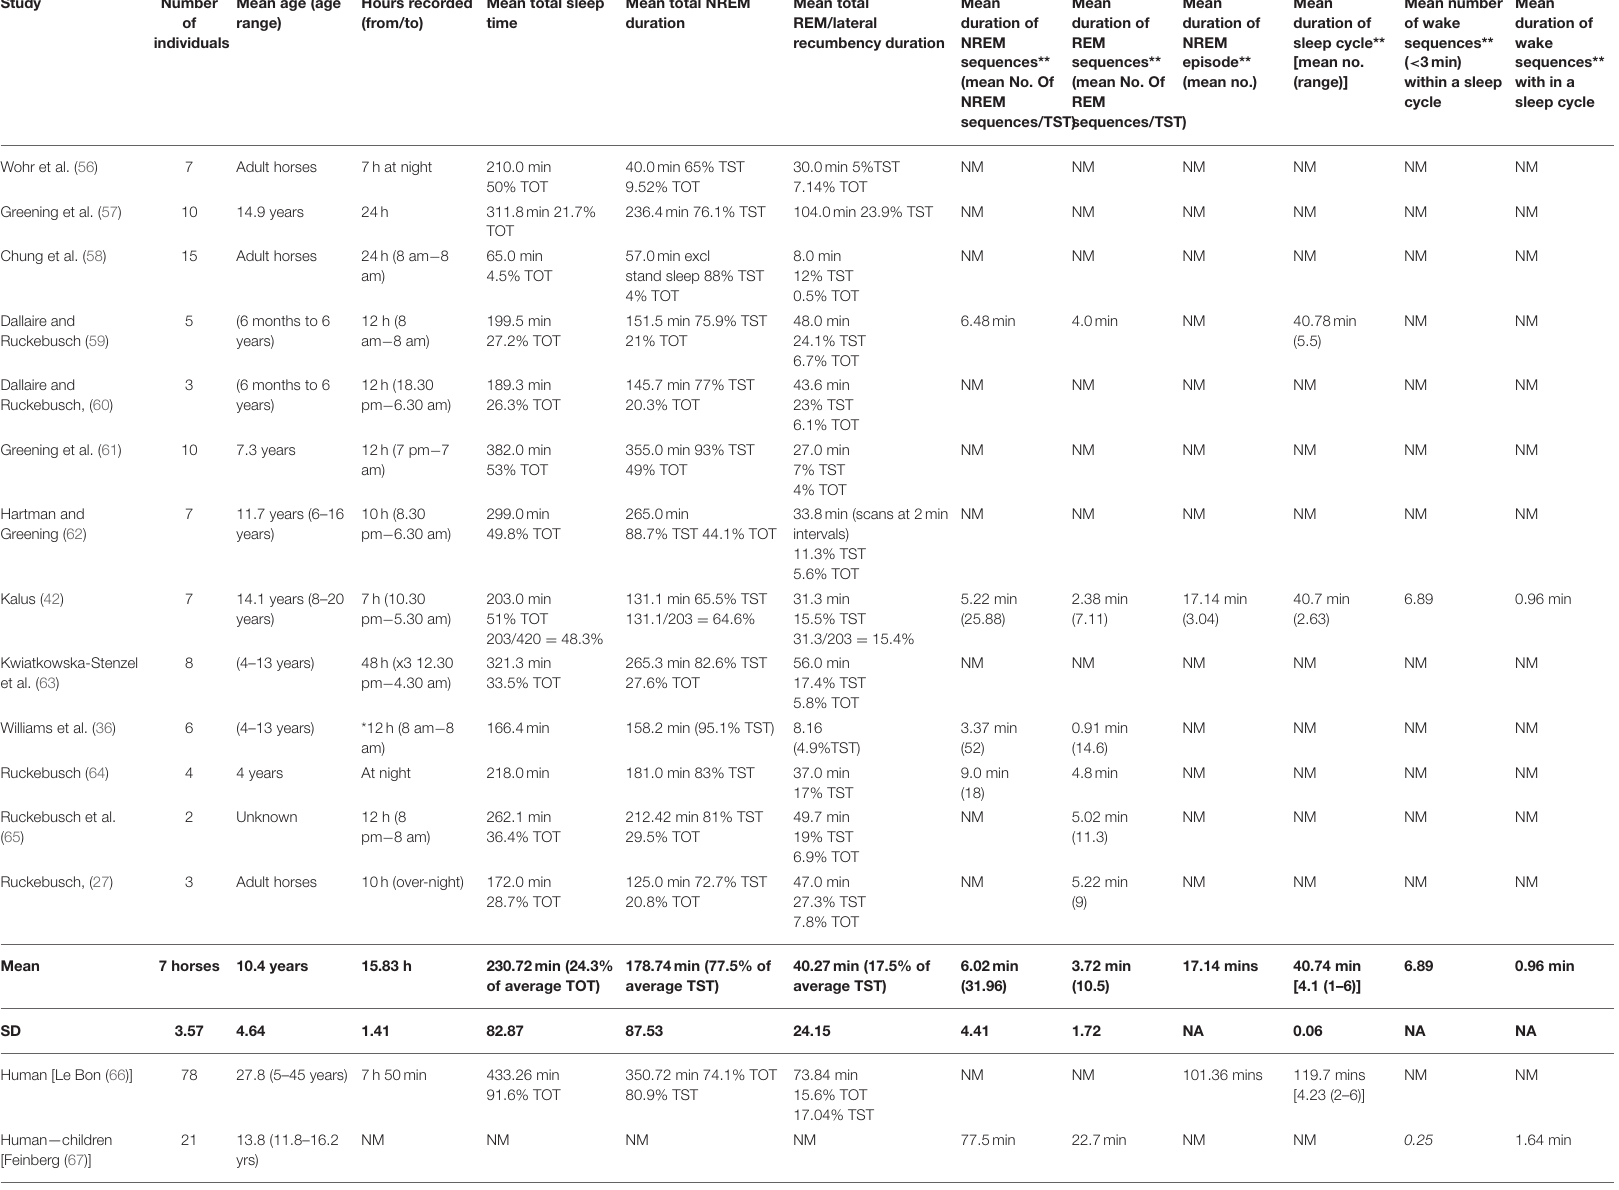
TABLE 3 | Reported measurements and characteristics of the equine and human sleep